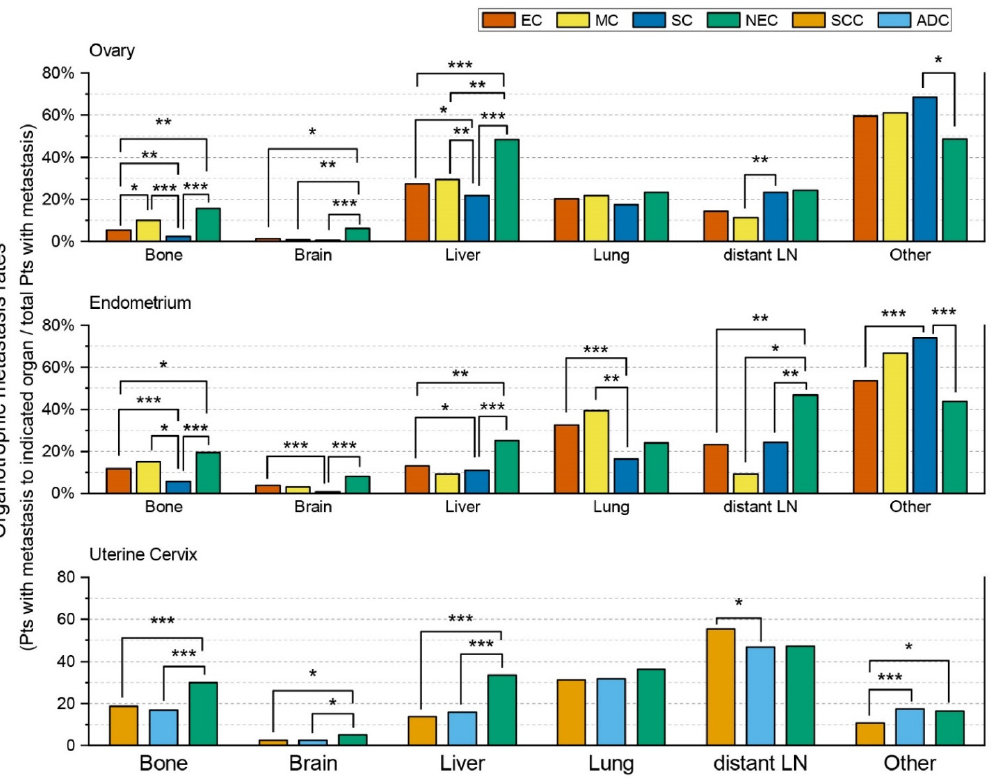
Figure 1. Comparison of organotrophic metastasis patterns between neuroendocrine carcinomas and representative non-neuroendocrine carcinomas of the uterine cervix, endometrium, and ovaries based on cases retrieved from the Surveillance, Epidemiology, and End Results (SEER) database. Only statistically significant comparisons are marked with asterisks (*, p ≤ 0.05; **, p ≤ 0.01; ***, p ≤ 0.001). (Abbreviations: EC, endometrioid carcinoma; MC, mucinous carcinoma; SC, serous carcinoma; NEC, neuroendocrine carcinoma; SCC, squamous cell carcinoma; ADC, adenocarcinoma; Pts, patients; LN, lymph